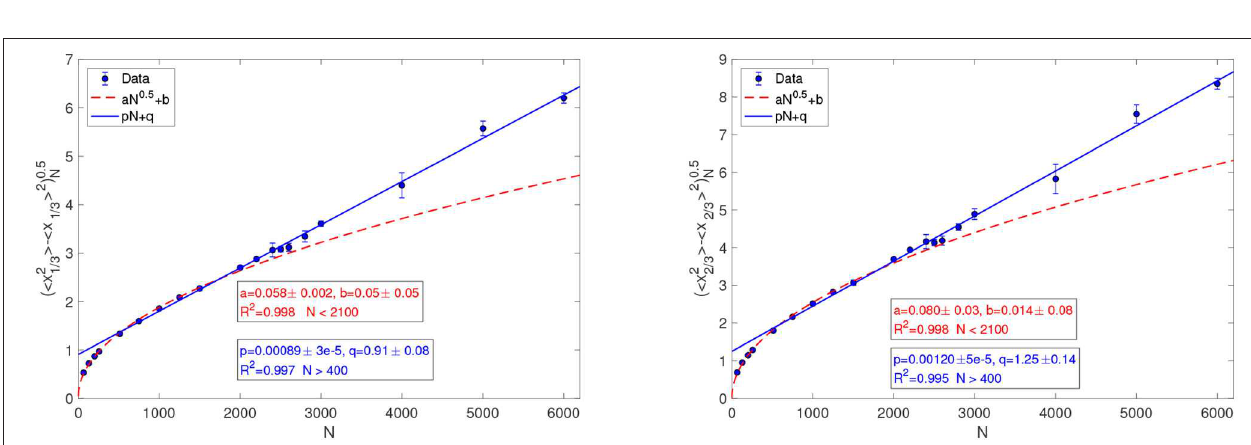
Frontiers in Physics |